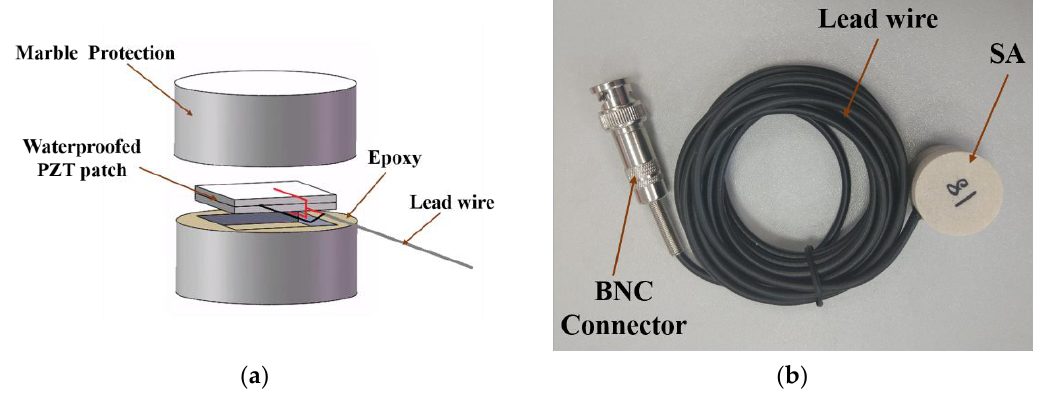
Figure 2. Smart Aggregate (SA): ( a ) The design illustration of a smart aggregate; ( b ) the photo of a smart aggregate.